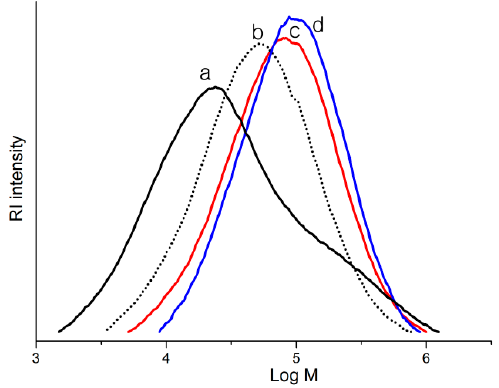
Figure 2. Gel permeation chromatography (GPC) curves of polymers generated with constrained- geometry catalyst (CGC)/[Ph 3 C][B(C 6 F 5 ) 4 ]/iBu 3 Al ( a , entry 7), 14 ( b ), 13 ( c ), and 18 ( d ) activated with